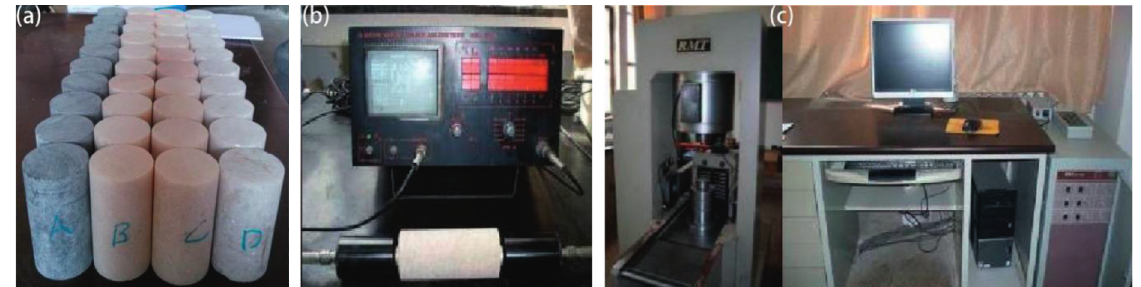
Figure 2: Specimen and test equipment: (a) marble specimen; (b) ultrasonic detector; (c) RMT-150B rock mechanical test system.